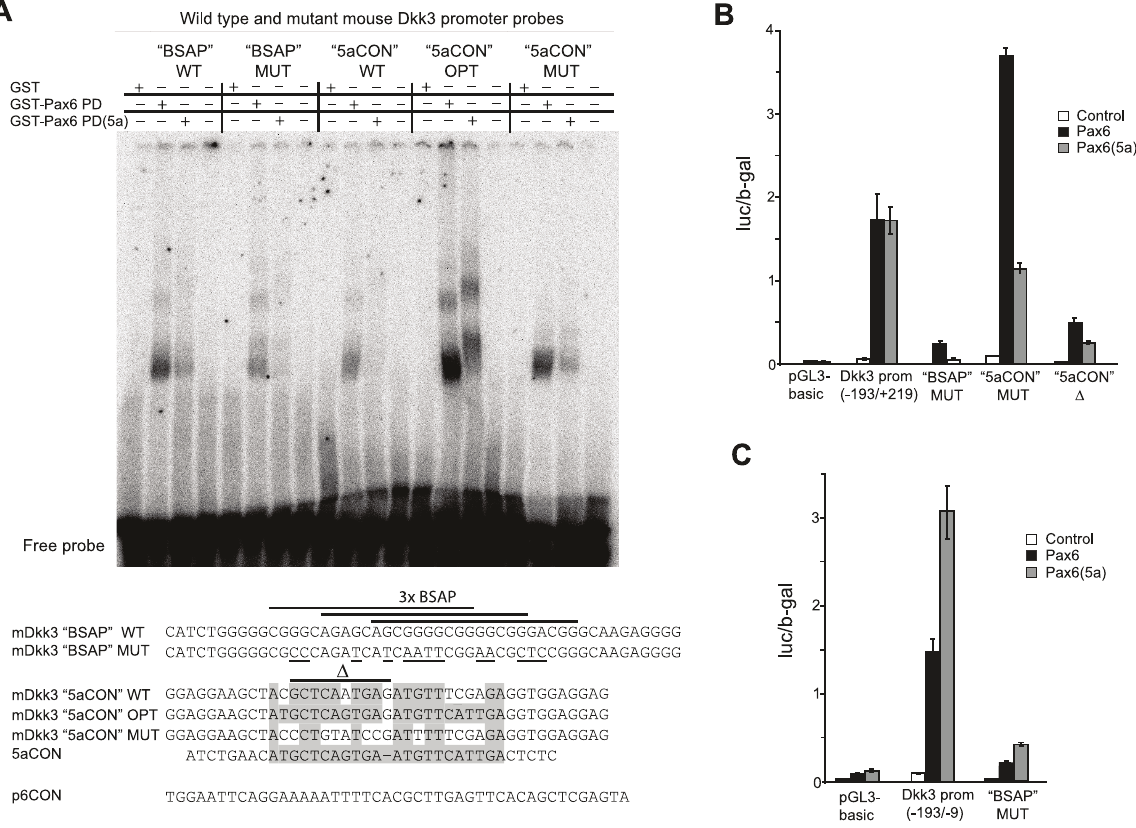
Figure 4. EMSA confirms direct binding by the Pax6 paired domain to an evolutionary conserved binding site in the mouse Dkk3 promoter, anda mutated version of this site is not longer able to mediate transcriptional activation by Pax6 from the Dkk3 promoter. A, affinity purified recombinant GST-fusion proteins containing the Pax6- or the Pax6(5a) paired domain (PD) were used in EMSA with a 55 bp probe covering the evolutionary conserved BSAP (Pax5) binding site in position 2 56/ 2 24 at the mouse Dkk3 promoter. A mutated version of this probe is also included. The ‘‘5aCON’’ WT probe (position + 180/ + 208 according to TSS-2), optimized (OPT) and mutated (MUT) versions of this probe were also used in binding reactions with recombinant Pax6 PD and Pax6(5a) PD. The sequences of the wild type (WT) and mutated (MUT) ‘‘BSAP’’ probes are shown beneath the gel. The exact localization of the three bioinformatically predicted- and overlapping BSAP sites is indicated by three lines above the ‘‘BSAP’’ probe sequence. The nucleotides changed in the ‘‘BSAP’’ MUT sequence are underlined. ‘‘5aCON’’ OPT is an optimized version, similar to the original 5aCONsequence. Grey bars show thehomologywith 5aCONforeach version of the mouse Dkk3 ‘‘5aCON’’ probes. B,transient transfectionsandreporter gene assays in HeLa cells with pGL3-mDkk3 promoter construct nr 2 ( 2 193/ + 219) containing the mutated ‘‘BSAP’’ and ‘‘5aCON’’ sites, and a deleted ‘‘5aCON’’ site (‘‘5aCON D ’’). The ten deleted nucleotides in the ‘‘5aCON D ’’ probe which is replaced with the dinucleotide TT are indicated by a D symbol above the sequence in A. C, transient transfections and reporter gene assays in HeLa cells with the minimal 184 bp pGL3-mDkk3 promoter construct, nr 6 ( 2 193/ 2 9) containing the mutated ‘‘BSAP’’ site. Transfections were done as described in figure 3.